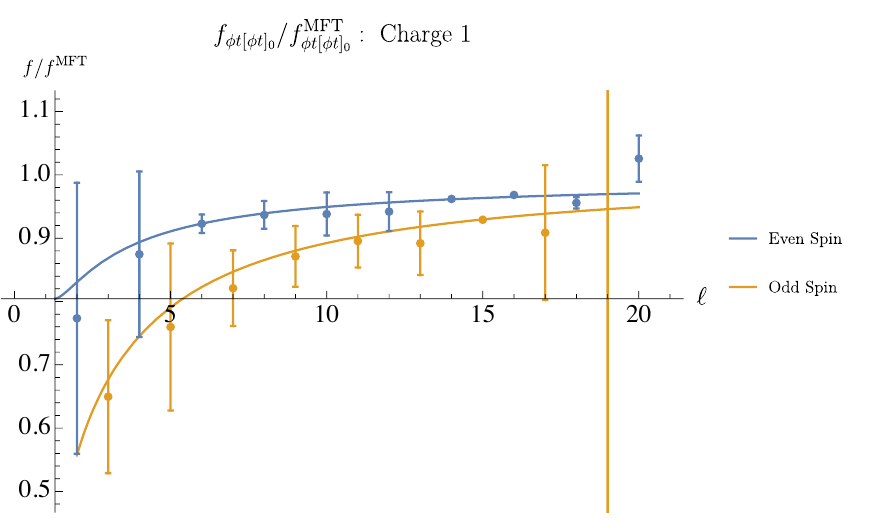
with charge 1 and both 0